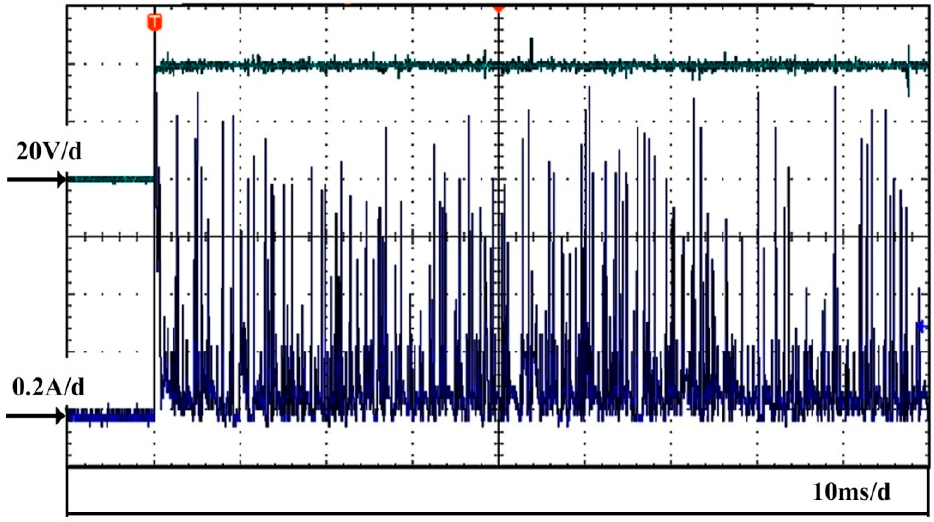
Figure 10. Voltage and current signals within a time period of 90 ms.